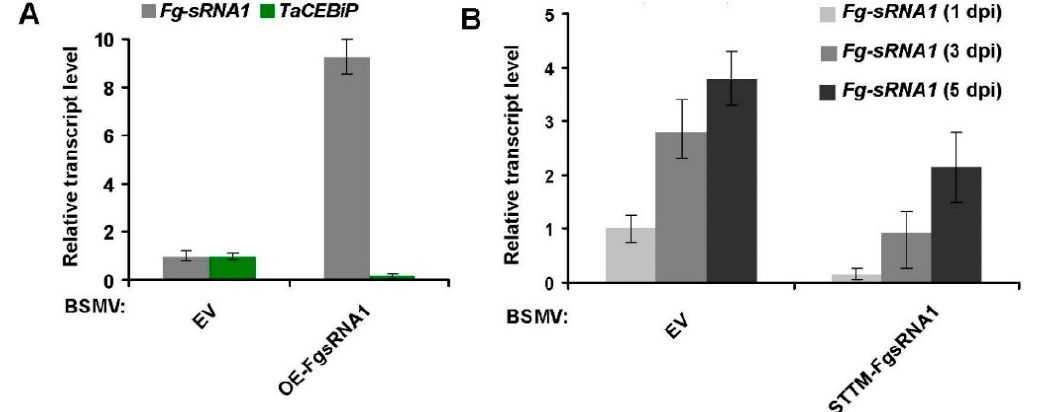
Figure 4. Detection of relative transcript level of Fg-sRNA1 and TaCEBiP from F. graminearum infected lesion area in BSMV pre-inoculated wheat leaves. ( A ) BSMV-based experiment procedures can be found in Materials and Methods section. After 15th day post BSMV constructs inoculation of wheat plants, segments of the 4th leaves of BSMV-infected (BSMV: EV&BSMV: OE-FgsRNA1) wheat plants were collected and then inoculated with F. graminearum (strain PH-1) by the punch inoculation method. Relative transcript levels of Fg-sRNA1 and TaCEBiP were detected by stem-loop RT-PCR and real-time qPCR assay at 1 dpi. Error bars represented standard error (SE) of three representing experiments from four replicates; and ( B ) similar to BSMV: OE-FgsRNA1infection and punch inoculation assay, BSMV-infected (BSMV: EV&BSMV: STTM-FgsRNA1) wheat leaves were collected and then inoculated with F. graminearum by the punch inoculation method. Relative transcript levels of Fg-sRNA1 were detected by stem-loop RT-PCR at 1, 3, 5 dpi, respectively. Error bars represented standard error (SE) of three representing experiments from four replicates.